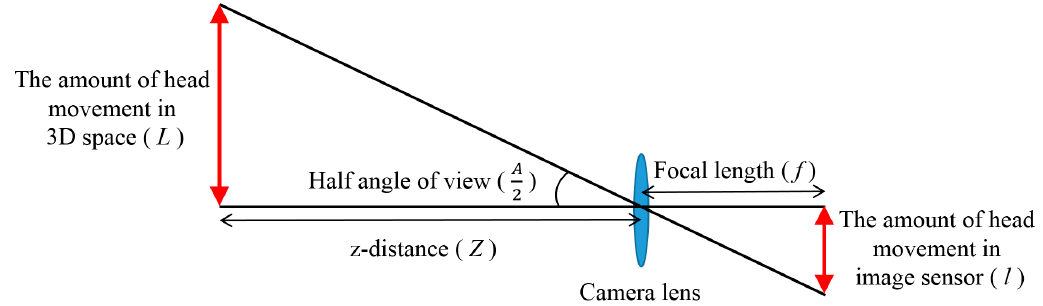
Figure 6. Measuring the amount of head movement in 3D space based on pinhole camera model and z -distance.